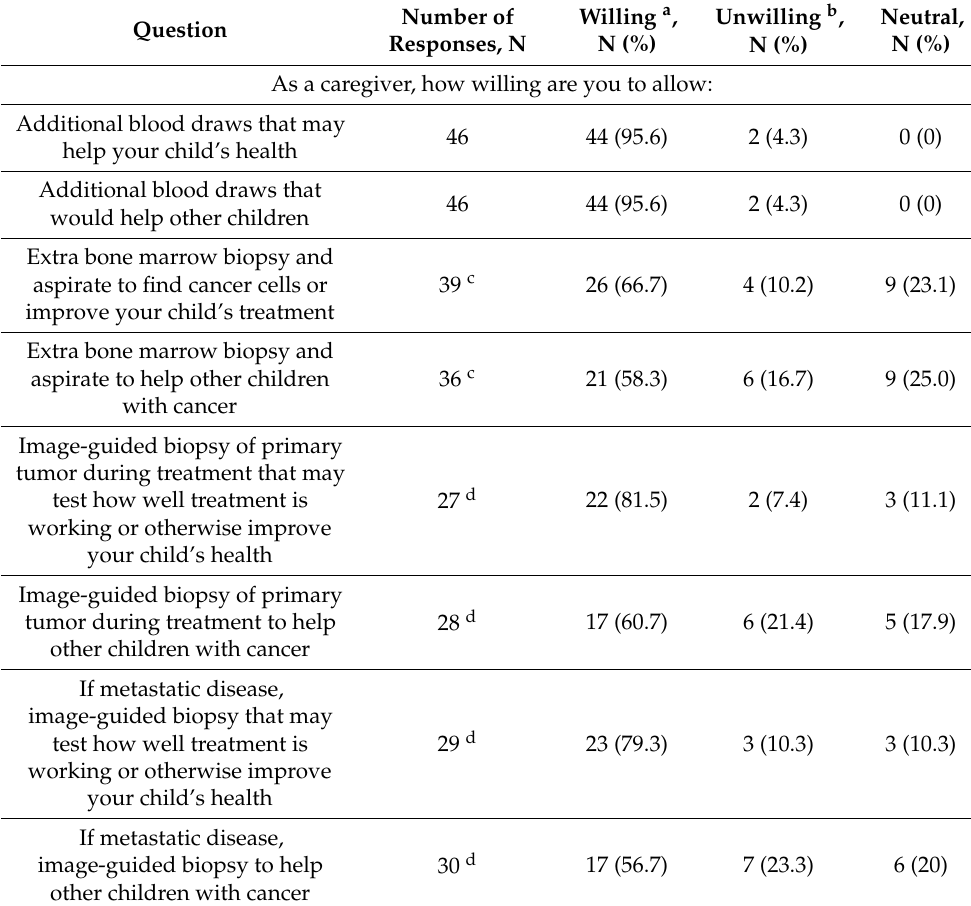
Table 2. Summary of caregiver survey responses regarding additional procedures that either provide or do not provide benefit to their